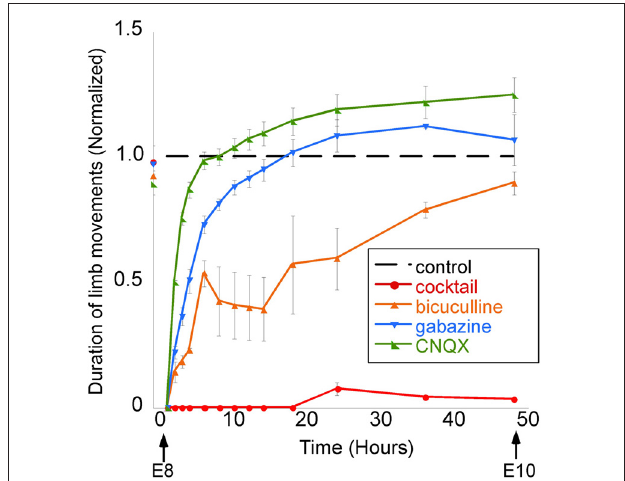
FIGURE 7 | GABAergic or glutamatergic receptors can be chronically blocked without a prolonged reduction of spontaneous network activity. Graph of the average amount of time chick embryos moved during a 5-min period of observation, obtained once every 0.5–12h. Data are normalized to control values at each observation time point/stage, thus producing the dotted line for comparison. Treatment with a single receptor antagonist transiently reduces embryonic movements; however, movements return to control levels within 12h. A mixture of gabazine, CNQX, strychnine, and APV nearly abolished limb movements for 48h. [Modified from Wilhelm and Wenner